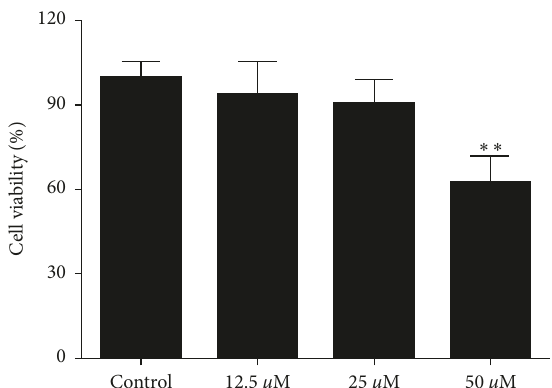
Figure 2: Effects of physalin B on cell viability of RAW264.7 macrophages. Each value indicated the mean results obtained from three independent experiments.